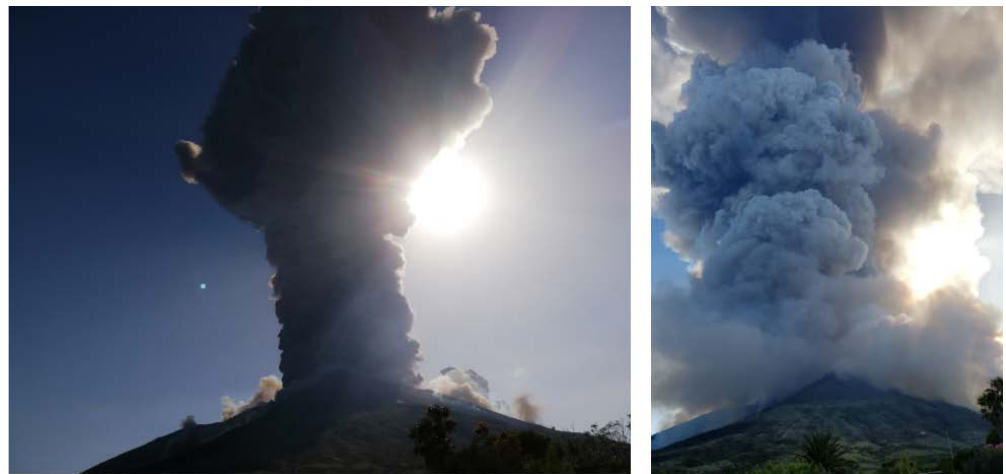
Figure 4. Pictures of the 3 July paroxysm at Stromboli volcano (photo courtesy of Gabriele Figure4. Scognamiglio).